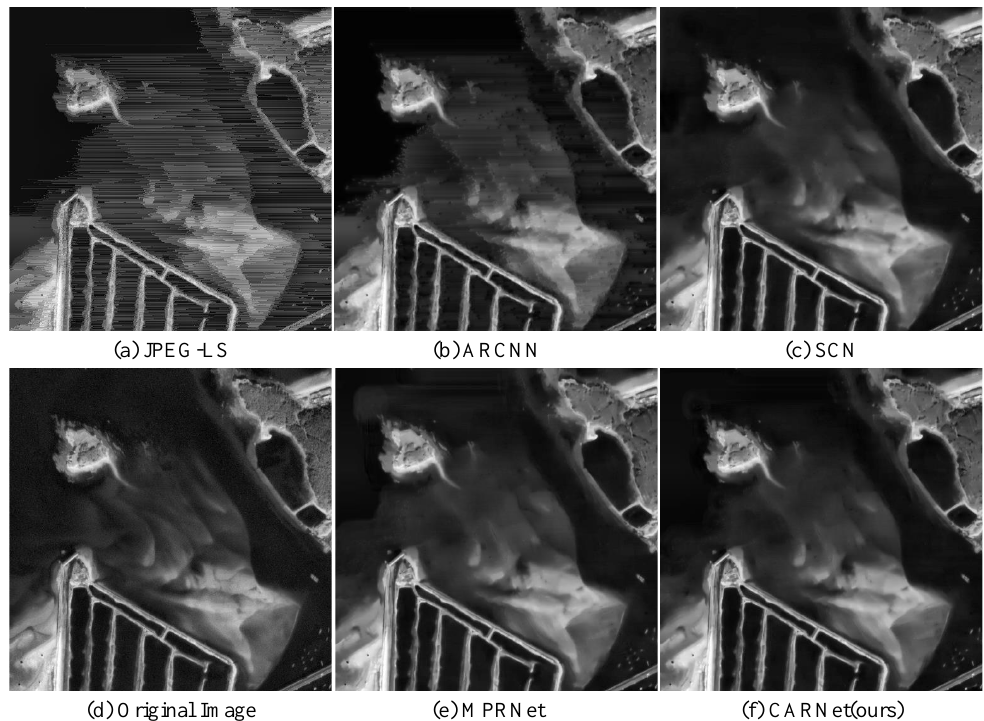
Figure 12. Visual comparison with state-of-the-art methods on a test 10-bit image patch (NEAR = 16).